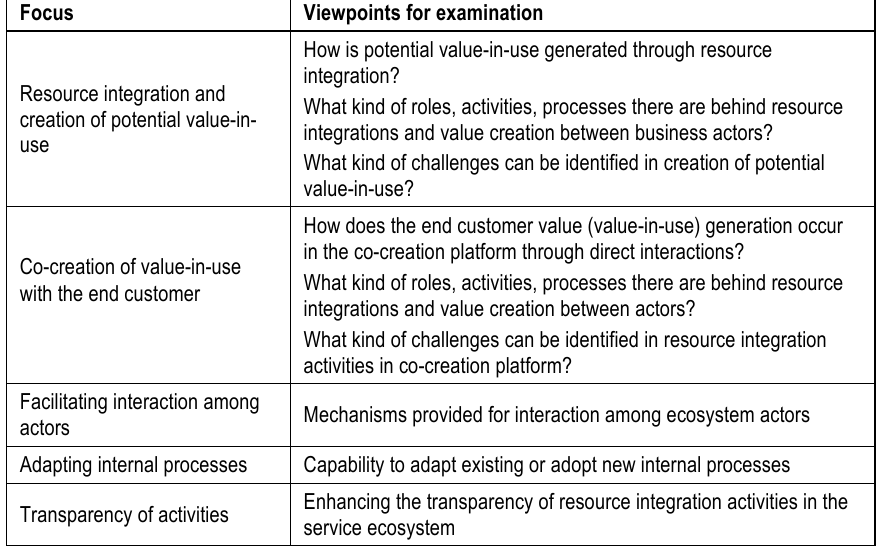
Table 2. Focus areas for examining value creation in the pilot case.